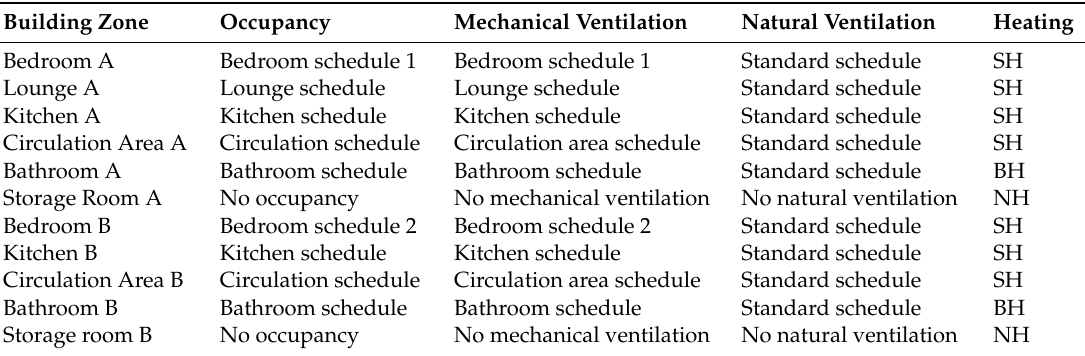
Table 1. Allocation of internal load schedules for every zone.